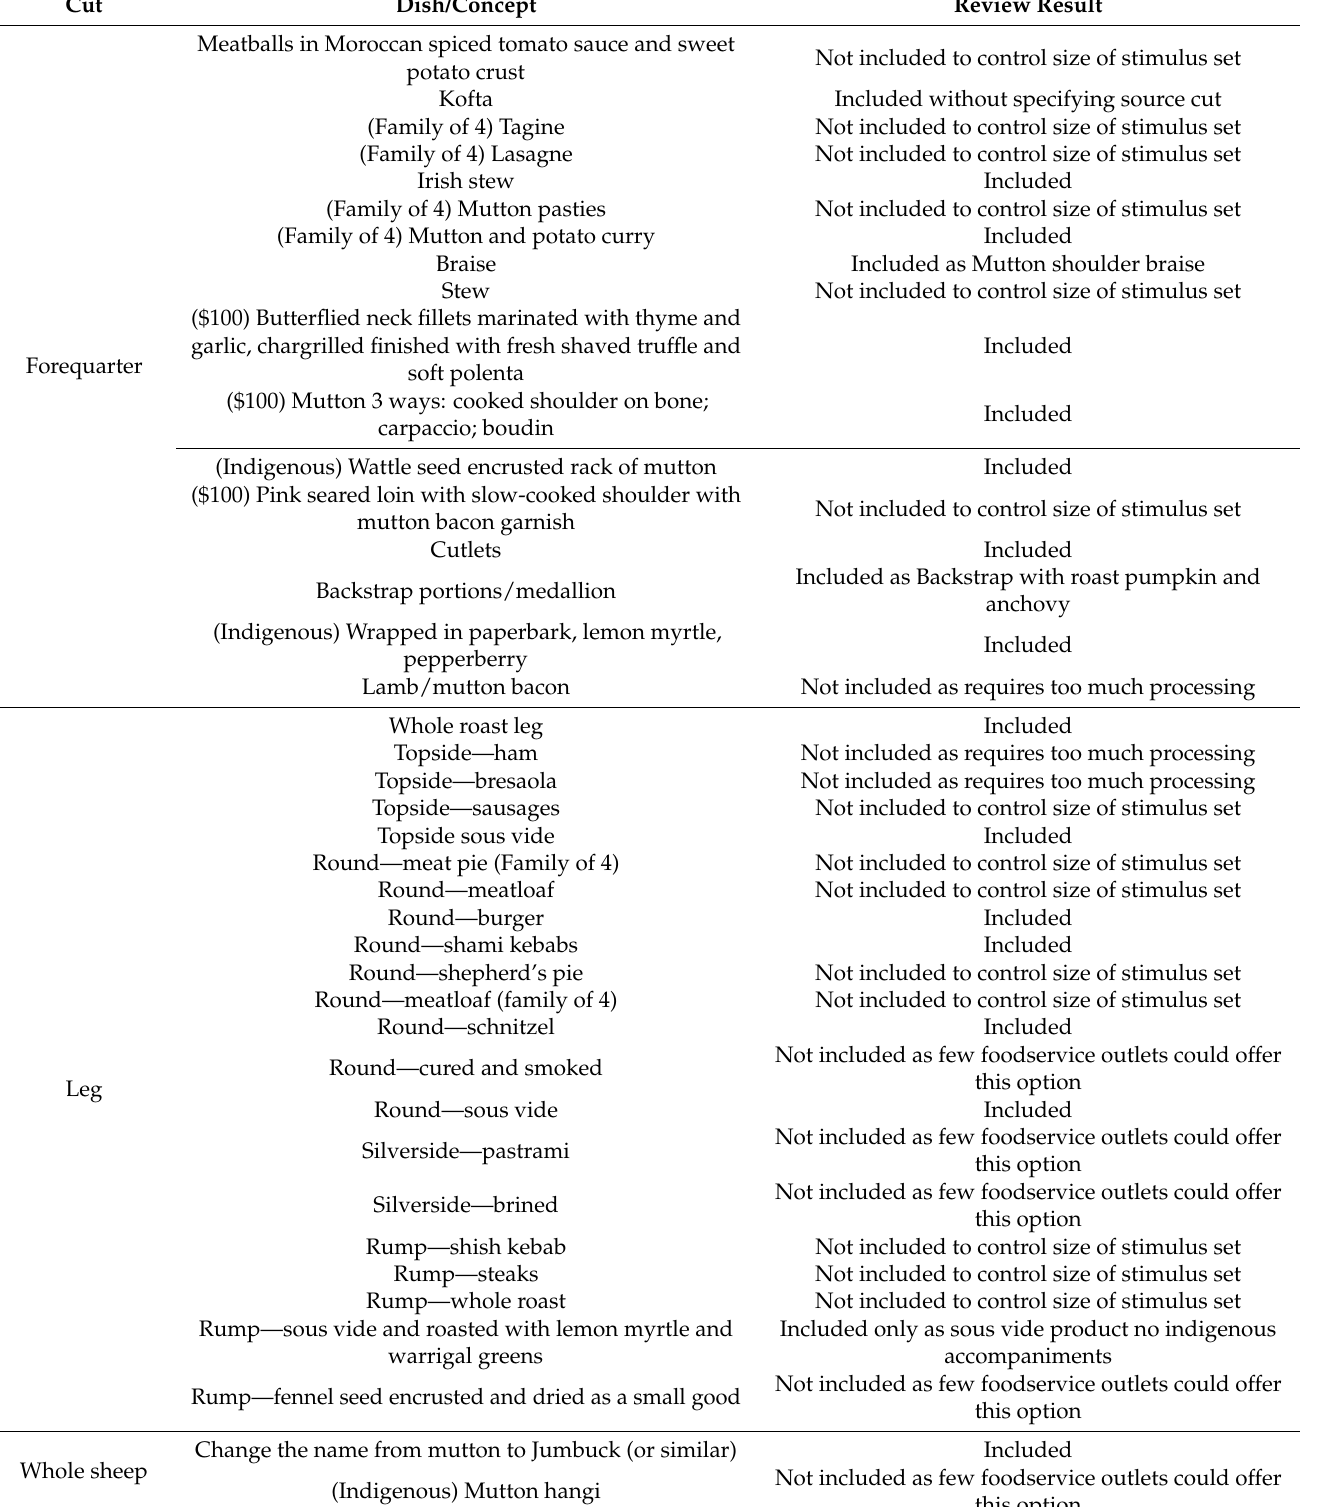
Table A1. Ideation session results (dishes and concepts) and result of review for inclusion in perceptual mapping.